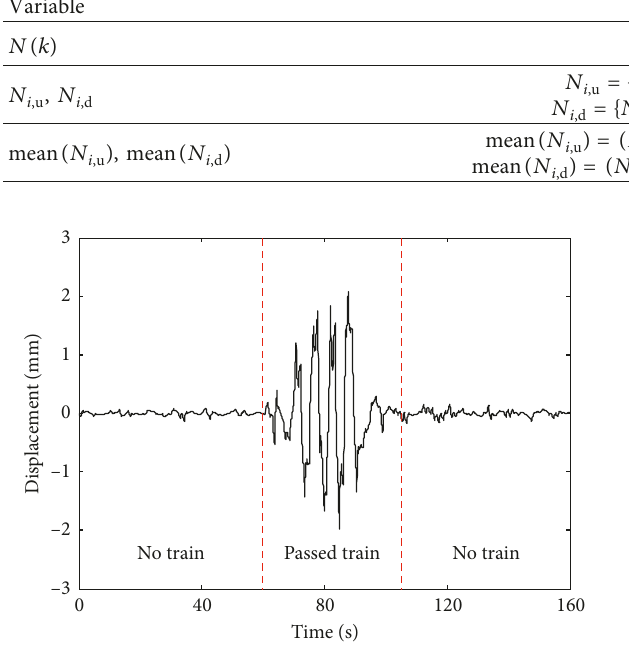
Figure 6: The dynamic displacement of B